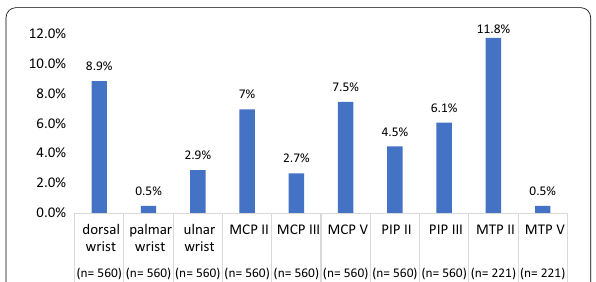
Fig. 2 Synovitis in MSUS. Inflammatory signs of the investigated joints with a synovitis score